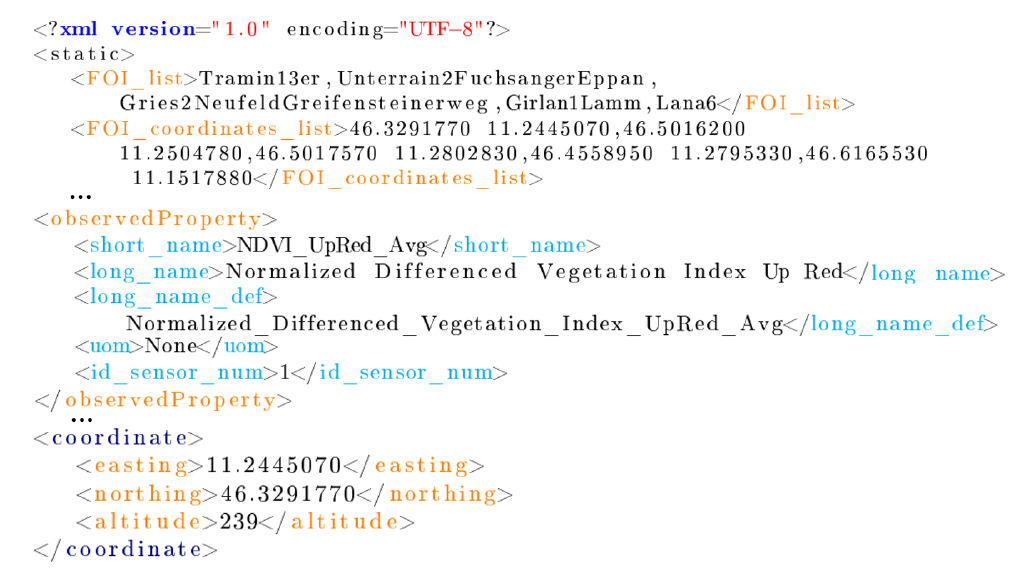
Figure 6. Creation of the configuration file: The XML fragment shows an example of some tags to be filled with the required